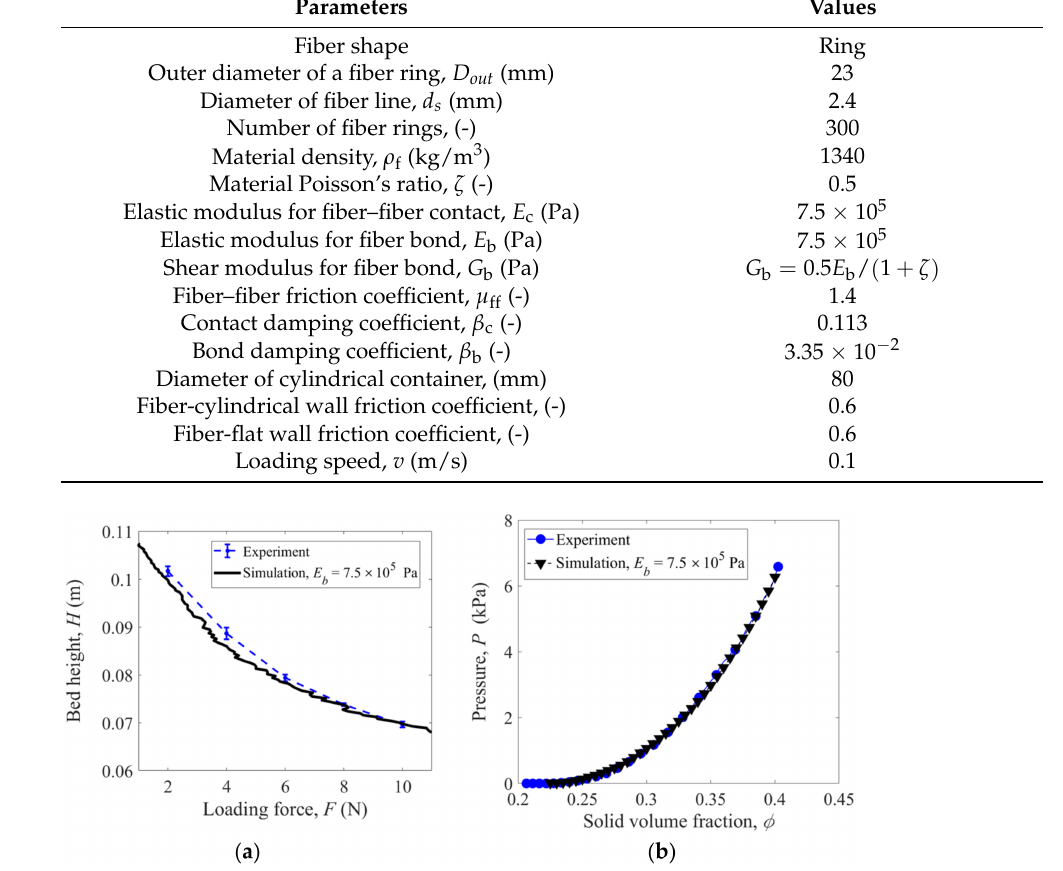
Figure 4. Comparison of experimental and simulation results with rubber rings: ( a ) bed height versus loading force and ( b ) pressure versus solid volume